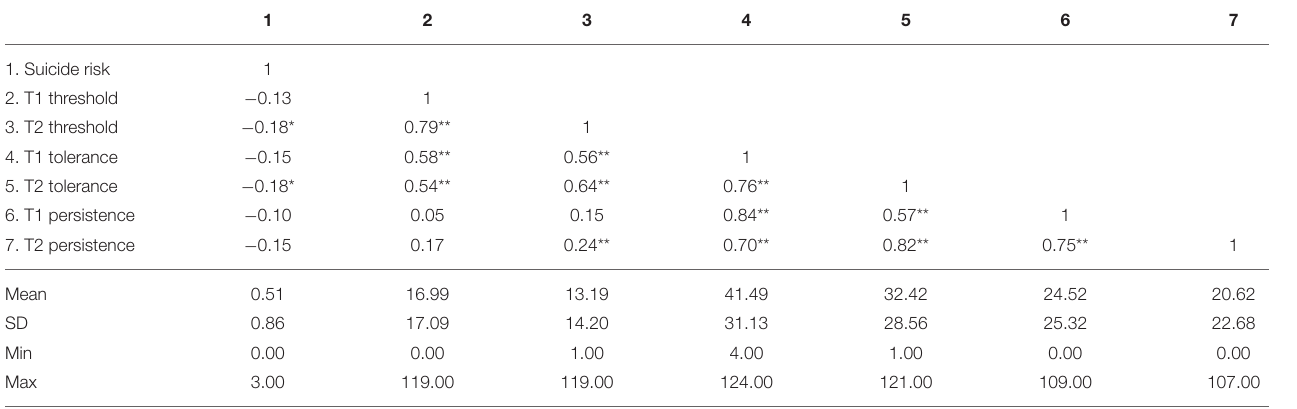
TABLE 2 | Study 1 correlations and descriptive